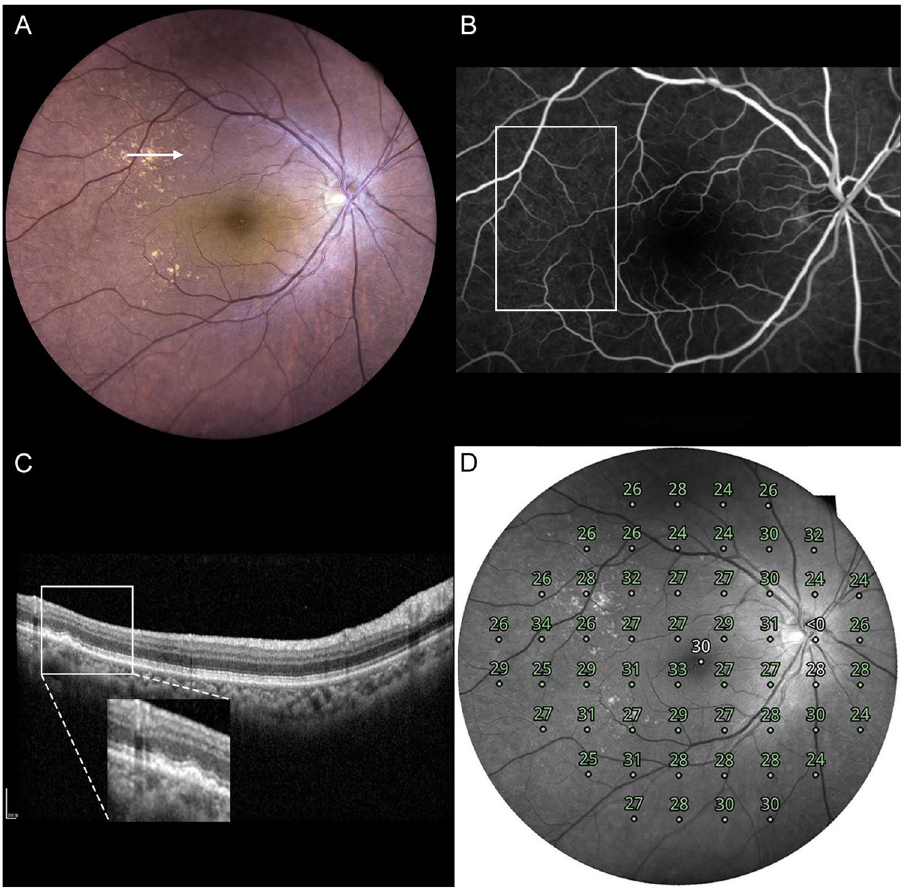
Figure 3. A representative case of type 2 cuticular drusen. A 70-year-old woman presented with type 2 cuticular drusen. ( A ) Color fundus photography showed numerous cuticular drusen. The cuticular drusen area was scanned using spectralis-domain optical coherence tomography (SD-OCT) (arrow). ( B ) Fundus fluorescein angiography showing hyperfluorescent drusen. This can confirm the diagnosis of cuticular drusen. ( C ) In the SD-OCT image scanned on the site of the arrow in Photo A, the cuticular drusen area is magnified to categorize the types of cuticular drusen. It can be diagnosed as a type 2 cuticular drusen in which sub retinal pigment epithelium triangular morphologic features, resulting in a saw-tooth appearance are present in a spectralis domain optical coherence tomography image. ( D ) Retinal sensitivity using microperimetry is topographically presented in a composited